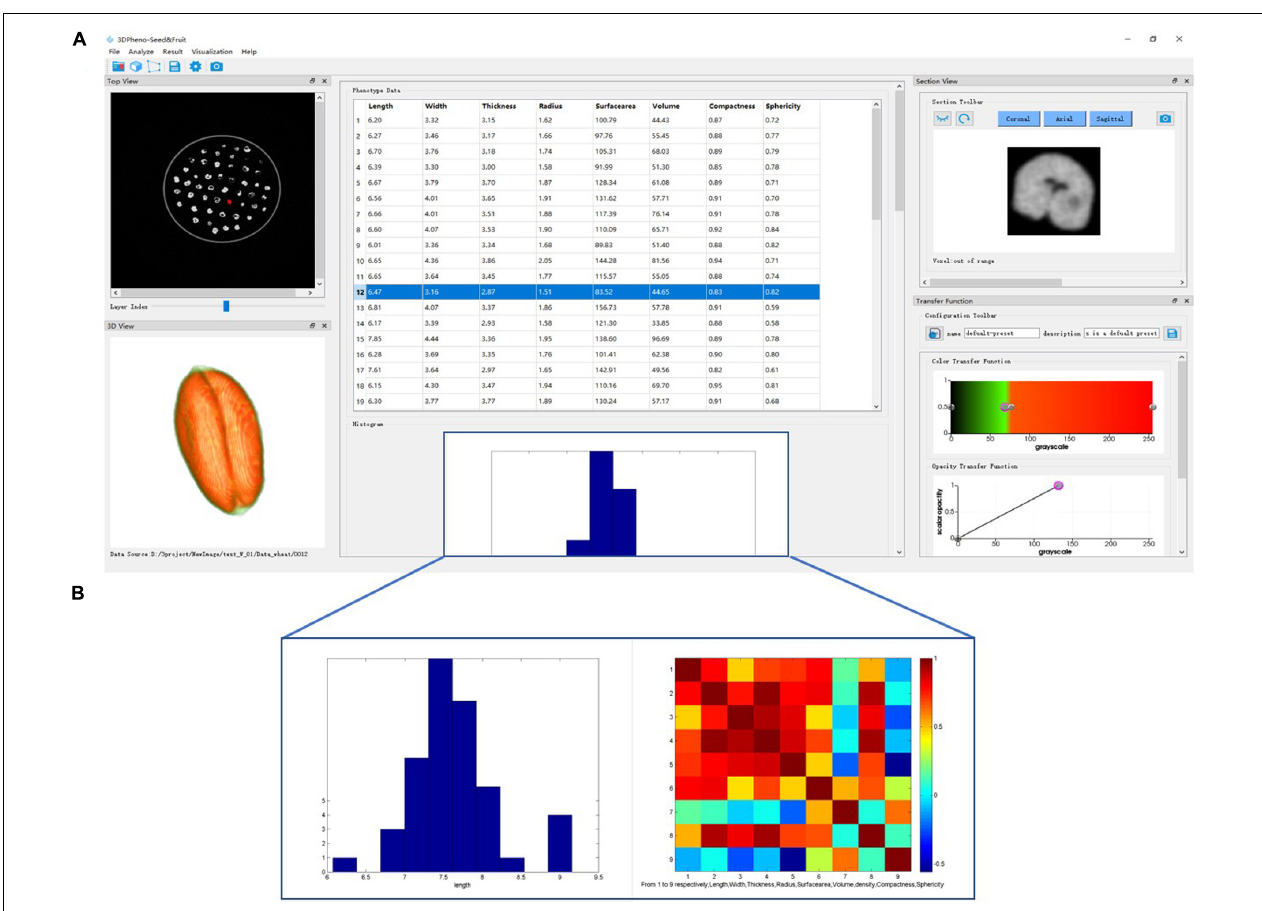
FIGURE 2 | 3DPheno-Seed&Fruit software interface with wheat data. (A) The main interface. (B) Example of histogram and correlation plots incorporated in the lower-middle of the interface.